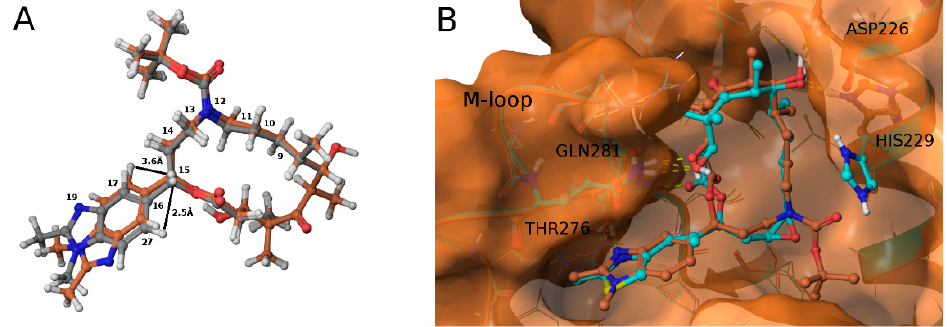
Figure 5. Tubulin-bound conformation of azathilone 2 and 3D model of its interaction with β -tubulin. ( A ) Overlay of the two conformers A ( orange ) and B ( grey ) of tubulin-bound azathilone 2 as derived from the TR-NOESY data; ( B ) 3D model of the azathilone 2 / β -tubulin complex ( 2 in orange, conformer B) as derived from TR-NOE and STD NMR experiments, docking, and CORCEMA-ST calculations and based on the structure of β -tubulin in complex with epothilone A [45] (for details see text). Epothilone A is shown in blue.